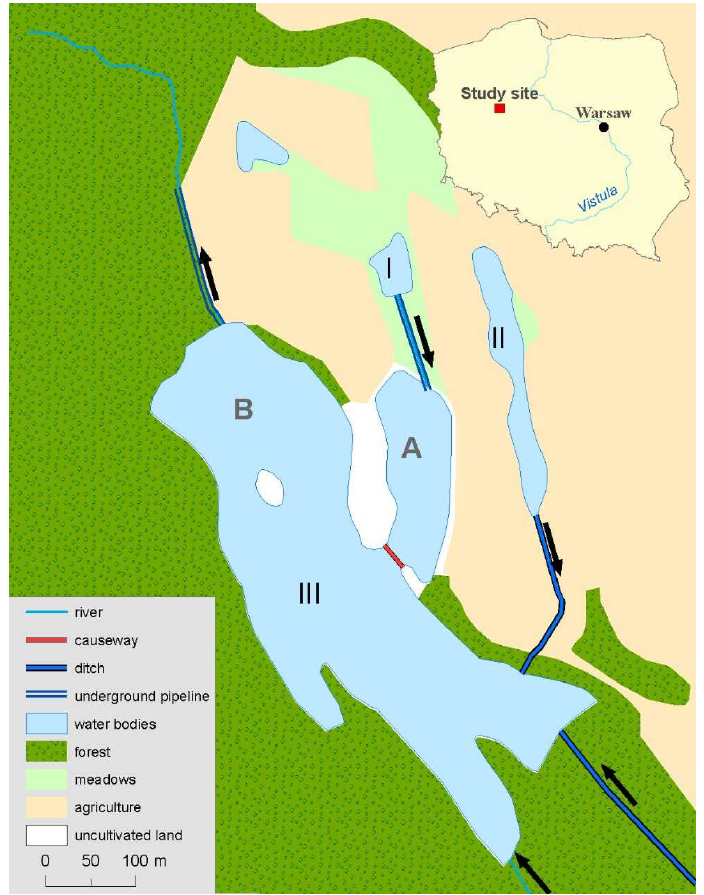
Figure 2. Sketch map of studied post-peat reservoir Nienawiszcz (III) after connection of both parts ( A , B ) and small post-peat reservoirs I and II, finished in years 1999 and 2000, respectively.